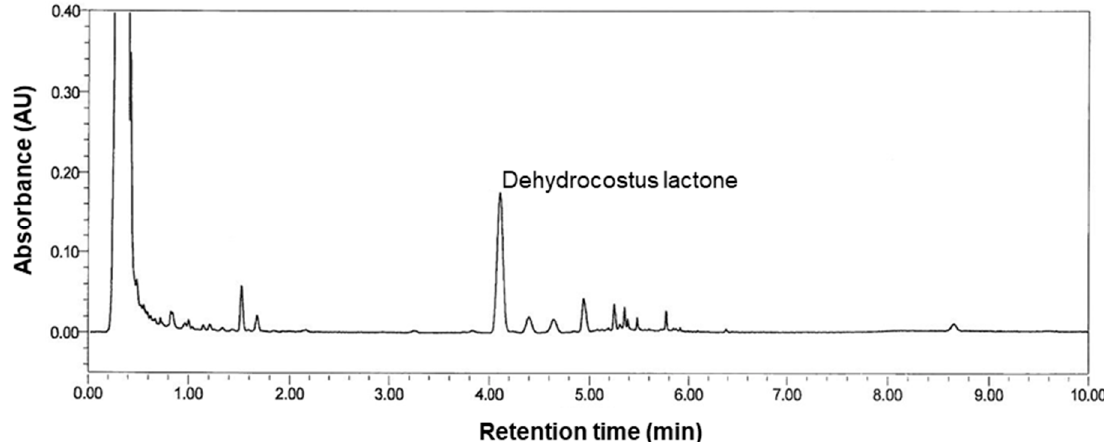
Figure 5. HPLC chromatogram of KM1608. The peak of dehydrocostus lactone in KM1608 was identified by comparison with the reference compound.